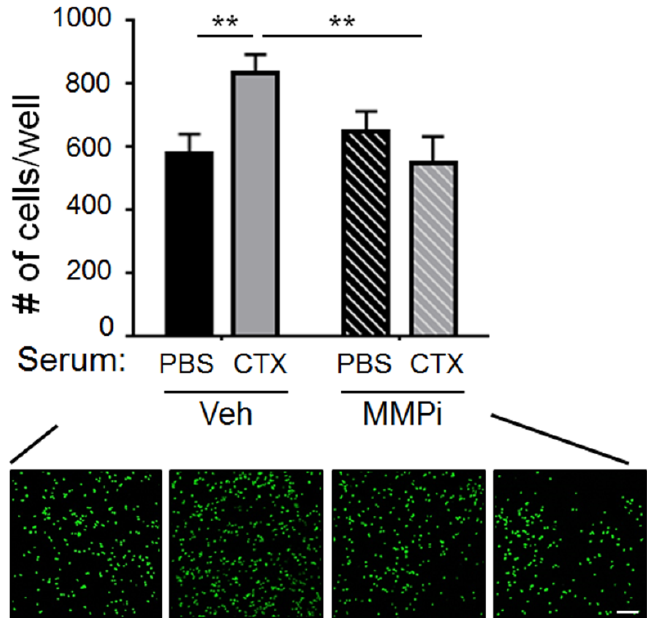
Figure 6. CTX-serum increased the binding of cancer cells to ECM in vitro. Plates coated with matrigel were pre-treated with PBS-serum or CTX-serum in the presence of MMPi or vehicle (Veh) before incubation with tGFP-MVT1 cells to assay their ability to allow cancer cell adhesion. Top: Quantification of cells per well after the indicated treatments ( n = 20 from 4 independent experiments). Bottom: Representative images. Scale bar, 100 μm. Bars indicate mean ± SEM; two-way ANOVA with post hoc Holm–Šídák correction; ** p < 0.01.